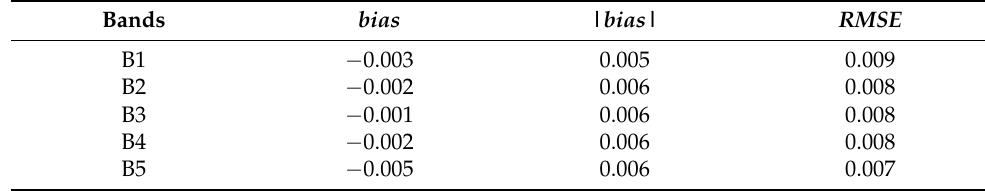
Figure 4. Comparison of surface reflectance curves between Landsat and simulated Landsat spectra: ( a ) for simulated Landsat bands, ( b ) for Landsat bands. Table 1. Statistics of validation of the Landsat OLI R rs .